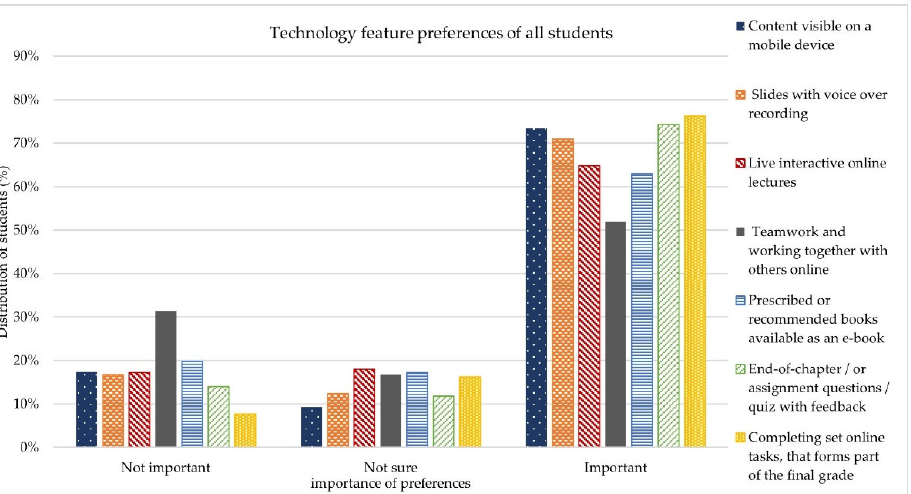
Figure 20. Online preferences of all students. Table 3. Preference for digital technology